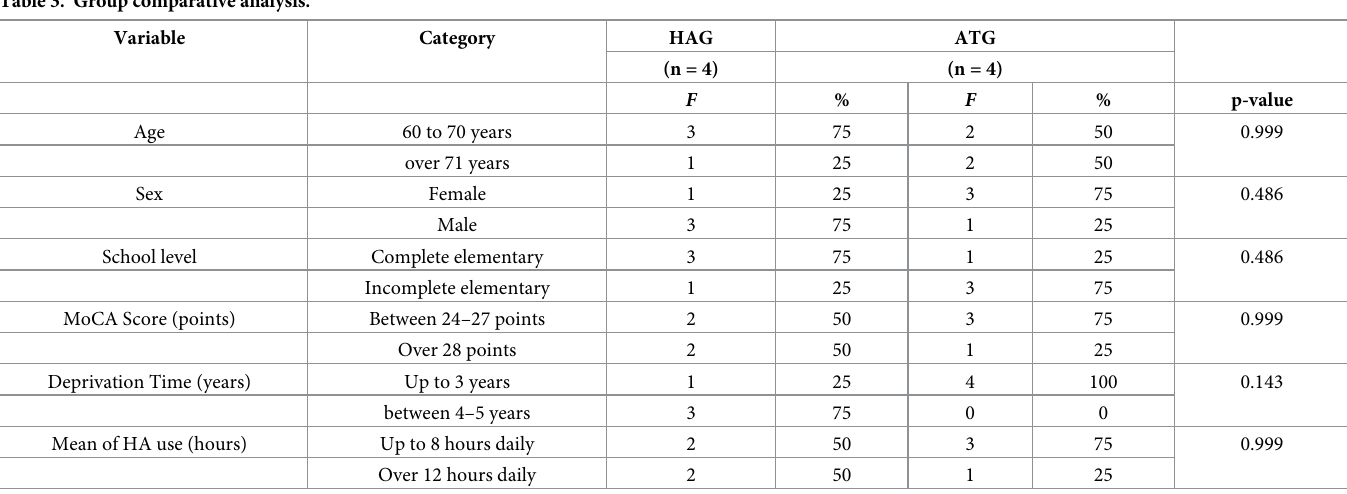
Table 3. Group comparative analysis.